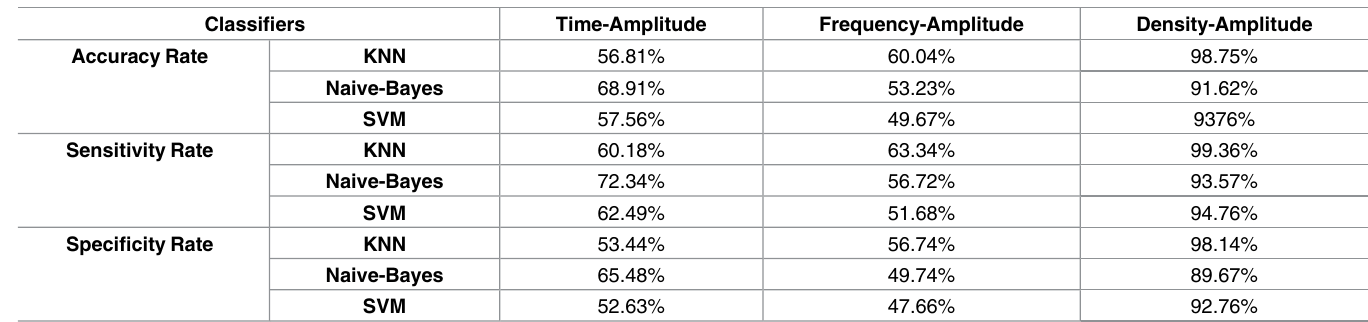
Table 3. Classification Success Rates of EEG